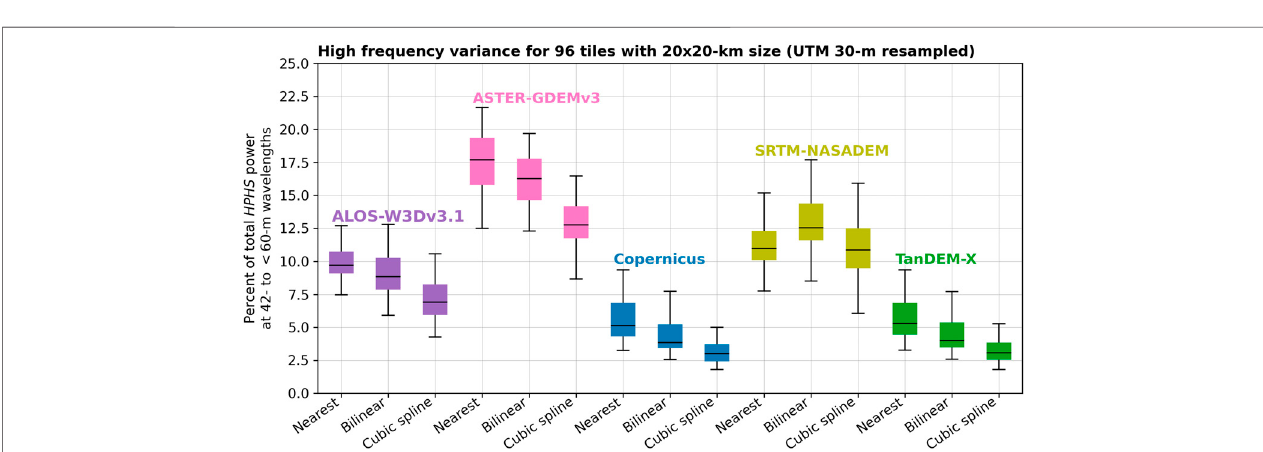
FIGURE 8 | Percent of total HPHS power (variance) at 42- to < 60-m wavelengths. Here, the DEMs are fi rst projected in UTM zone 19S and resampled to 30-m squarepixels.Threeresamplingschemesareshown,withadditionalresultsin SupplementaryFigureS2 .ForeachDEM, thehigh-frequencypower wascalculatedfor 96 square ( ∼ 20-km) tiles. The distributions are shown as boxplots with center line showing the median, box showing the interquartile range (IQR), and caps showing values at ± 1.5 × IQR. Outliers are not shown. For all DEMs, except the SRTM-NASADEM, the nearest neighbor resampling has the highest variance and these decrease with larger window sizes (bilinear) and higher order (cubic spline) approaches. The relative impact of smoothing is strongest for the ASTER-GDEMv3. We note that larger-window resampling schemes also affect real topographic features.